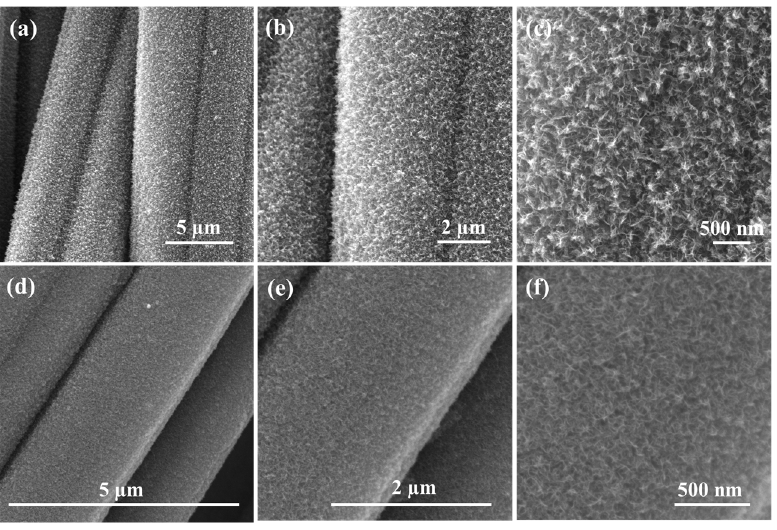
Figure 2. SEM images of Na 0 -MnO 2 ( a – c ); Na 3 -MnO 2 ( d – f ).